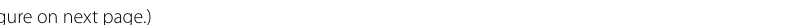
(See figure on next page.) Fig. 2 Odds ratio of 50% MRR over Weeks 1 ‒ 12 in PROMISE-2 subgroups defined by baseline demographics and patient-reported outcome ≥ measures. CI, confidence interval; EQ-5D-5L, EuroQol 5-dimension, 5-level scale; HIT-6, 6-item Headache Impact Test; MHDs, monthly headache days; MMDs, monthly migraine days; MRR, migraine responder rate; OR, odds ratio; PI-MBS, patient-identified most bothersome symptom; SF-36, 36-item Short-Form Health